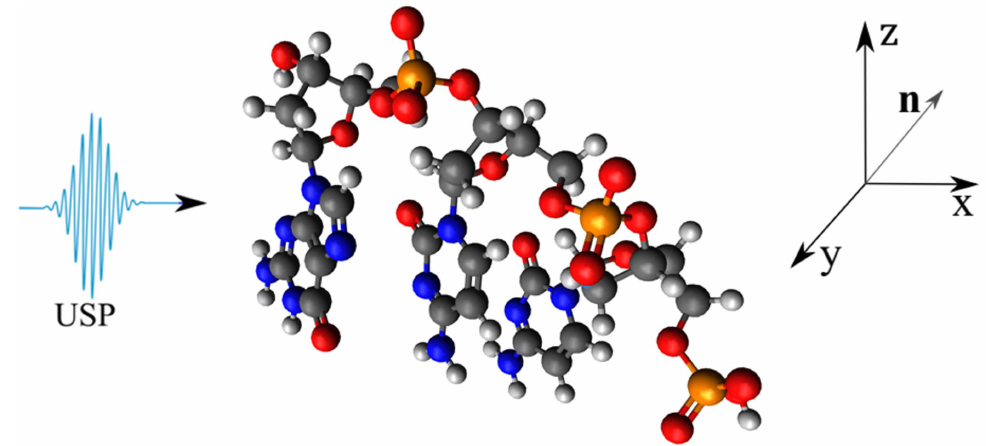
Figure 3. The same as in Figure 1, but only for trinucleide CCG.